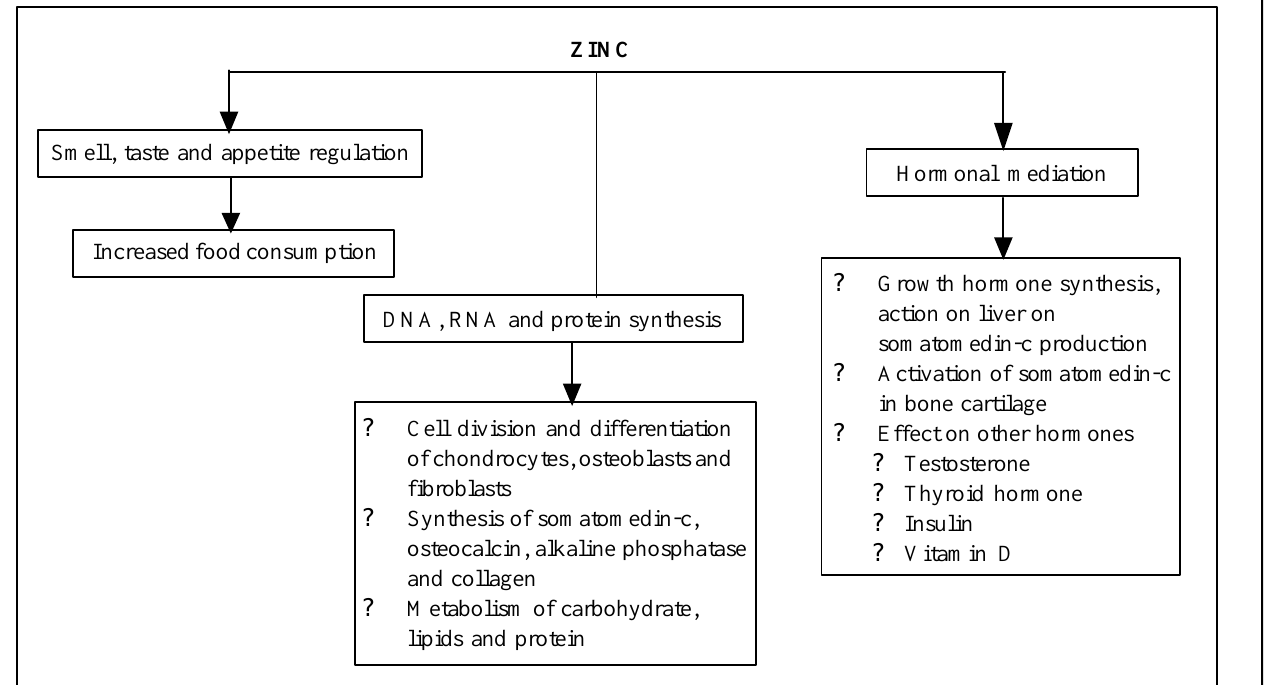
Fig. 1 : The mechanisms of zinc for growth and development (Reproduced from reference 15)